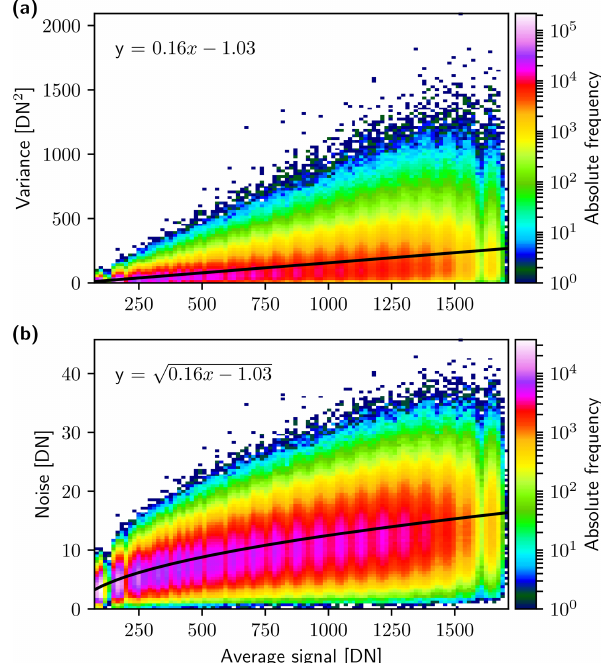
Figure 10. Two-dimensional histograms of the variance (DN 2 ) (a) and the noise (DN) (b) of the measured signal as a function of the averaged signal of the R channel. The black lines are least-square fits, which are parameterized as indicated by the respective equation in the